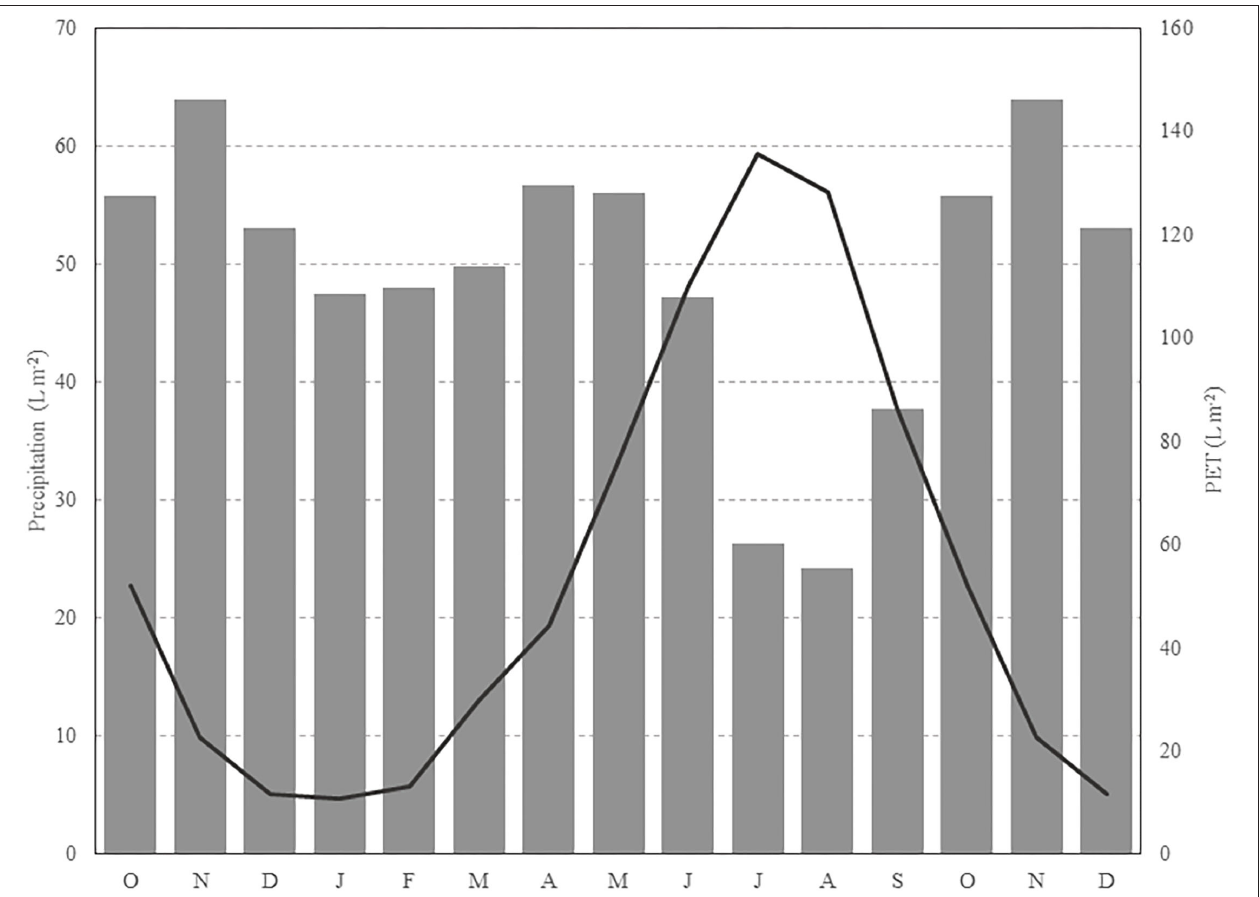
FIGURE 1 | Monthly average rainfall (bars) and potential evapotranspiration (PET, solid line) data at the experimental site. Source data series: 1925–2018 (60).